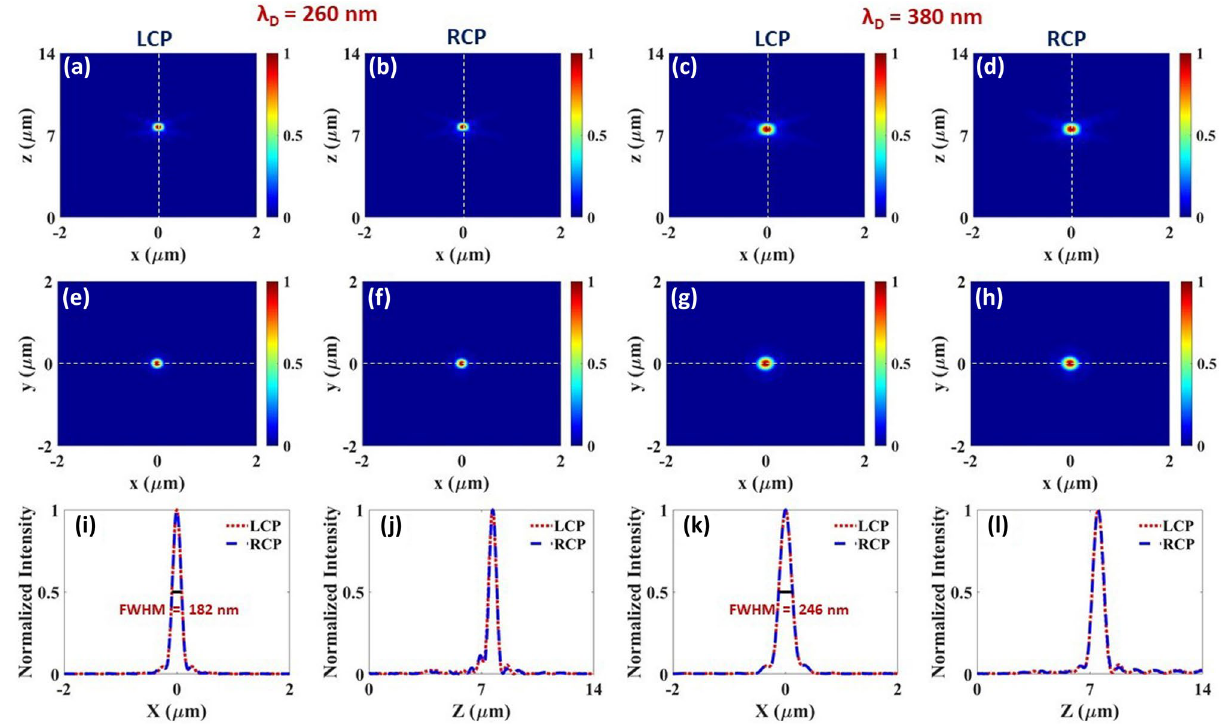
Figure 4. ( a – d ) Normalized intensity profiles of the focal spot of the hybrid metalens at x − z plane ( y = 0 ) for (cid:31) = 260 nm and 380 nm under both LCP/RCP illuminations respectively. ( e – h ) Normalized intensity profiles d of the focal spot of the hybrid metalens at x − y plane ( z = f ) at (cid:31) d = 260 nm and 380 nm under LCP, RCP illumination respectively. ( i , k ) depicts the intensity profile at the corresponding horizontal dashed lines shown at ( e – h ), at y = 0 , giving similar FWHM values under both LCP and RCP polarization. ( j , l ) shows the intensity profile at the corresponding vertical dashed lines shown at ( a – d ), at x = 0 . All the designed metalenses have the same diameter of 20 µ m and NA ≈ 0.8 .